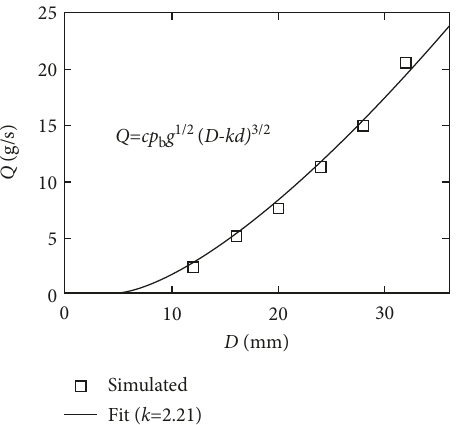
Figure 15: Mass flow rate versus the outlet sizes for particles with aspect ratios about 3:1, the outlet sizes range from 6 d Symbol: simulated data, line: fitted by using the Beverloo’s